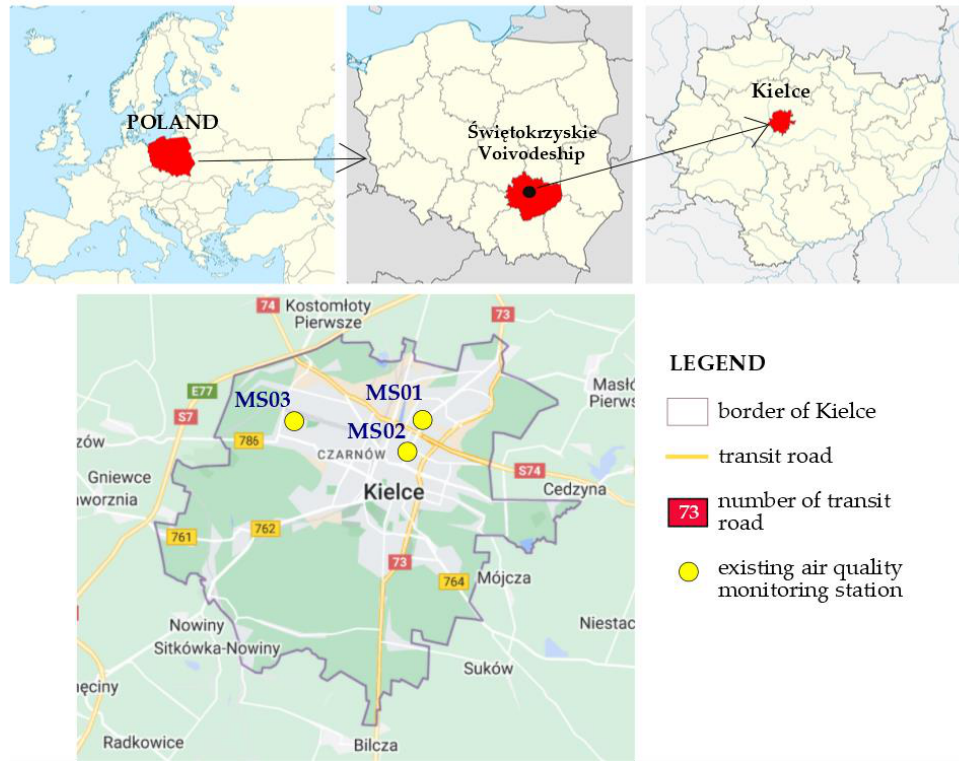
Figure 1. Location of Kielce against the background of maps of Europe and Poland, along with the location of existing air quality monitoring stations. Table 1. Specification of air monitoring stations in Kielce city.